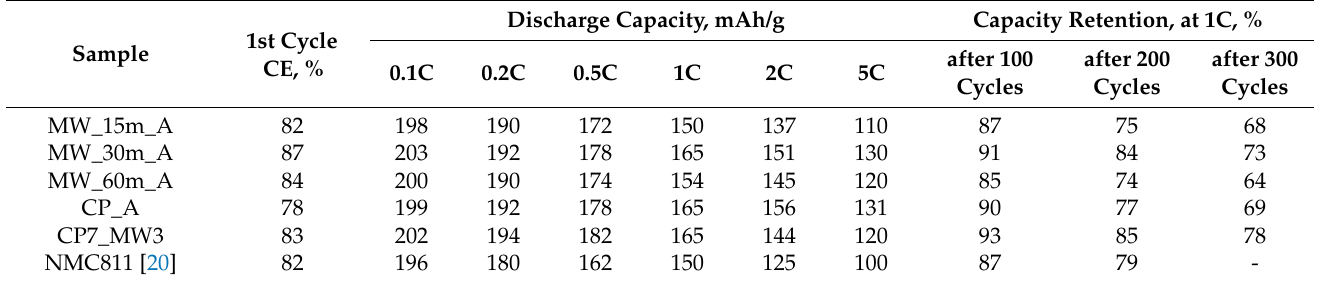
Figure 9. Rate capability ( a ) and cycling stability at 1C rate ( b ) of the MW NMC811 samples. Table 3. Discharge capacity and capacity retention for the MW and CP NMC811